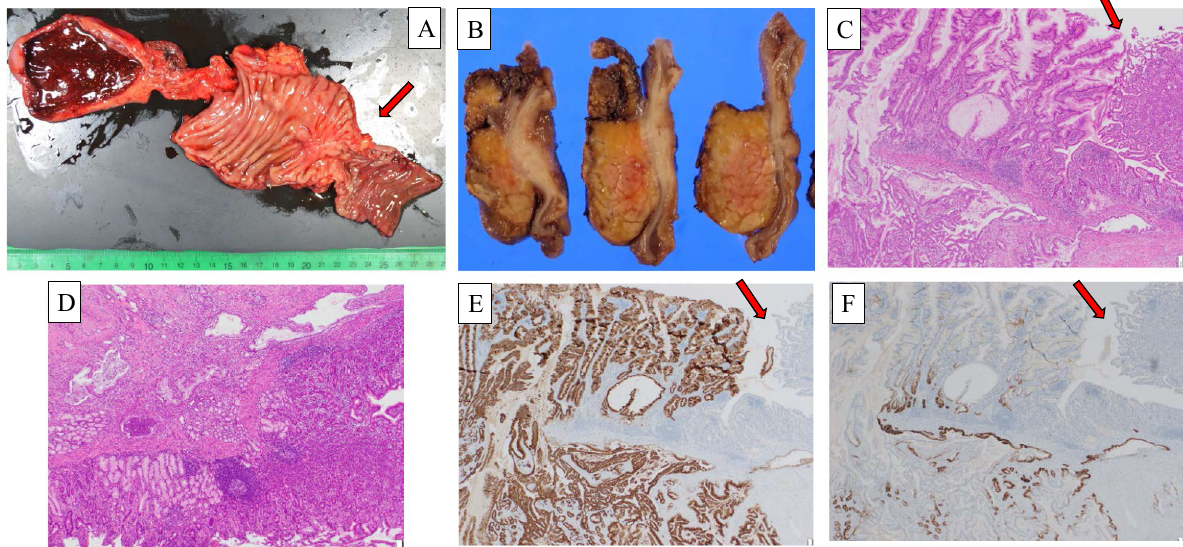
Fig. 2 Histopathological findings and immunohistochemical staining test. The resected specimen showed a 40 30 mm tumor on the descending × part of the duodenum slightly more distal to the papilla of Vater, and a white thickening of the duodenal wall was observed on the sectioned surface of the same area ( A , B ) (red arrow). There was an infiltrative growth of carcinoma cells with a predominant component of well to poorly differentiated tubular adenocarcinoma under the normal duodenal mucosa ( C , D ). The non-tumor duodenal epithelium is observed in the upper right corner of this image (red arrow), showing the continuous infiltration of the intramucosal hypodense lesion into the submucosal layer of the duodenal epithelium ( C ). Cancer cells were developing under the duodenal submucosa and infiltrated into the duodenal muscularis propria ( D ). The immunostaining of the same area showed that MUC5AC, which stained the gastric crypt epithelium, was diffusely positive in the intramucosal and tumor-infiltrated area, whereas MUC6 was negative to partially positive in the mucosa and positive in approximately 50% of the infiltrated